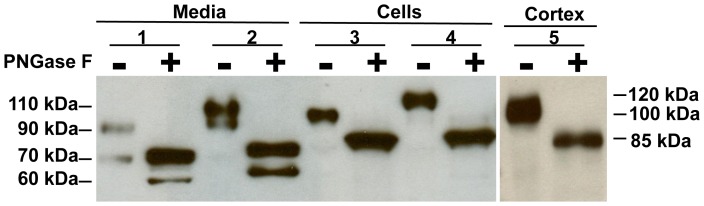
Deglycosylation of ACE2 protein in media and cell lysates from mouse PT cells.Representative immunoblot for ACE2 treated without (−) or with (+) deglycosylation with PNGase F in the media (Lanes 1–2) and cell lysates (Lanes 3–4). Lanes 1 and 3: wildtype PT cells, Lanes 2 and 4: ACE2 knockout (KO) PT cells transfected with a human ACE2 vector, Lane 5: mouse kidney cortex. Lanes 1+ and 2+ show a reduction in the sizes of ACE2 fragments in media fractions to ∼75 kDa and ∼60 kDa for mouse ACE2, and to ∼80 kDa and ∼65 kDa for human ACE2, respectively. Lanes 3+ and 4+ show a reduction in the sizes of ACE2 in cell lysates to ∼85 kDa for both mouse and human ACE2 treated with the PNGase F, respectively. Lane 5+ shows a reduction in size of ACE2 in mouse cortex from ∼100 kDa to ∼85 kDa after treatment with PNGase F.